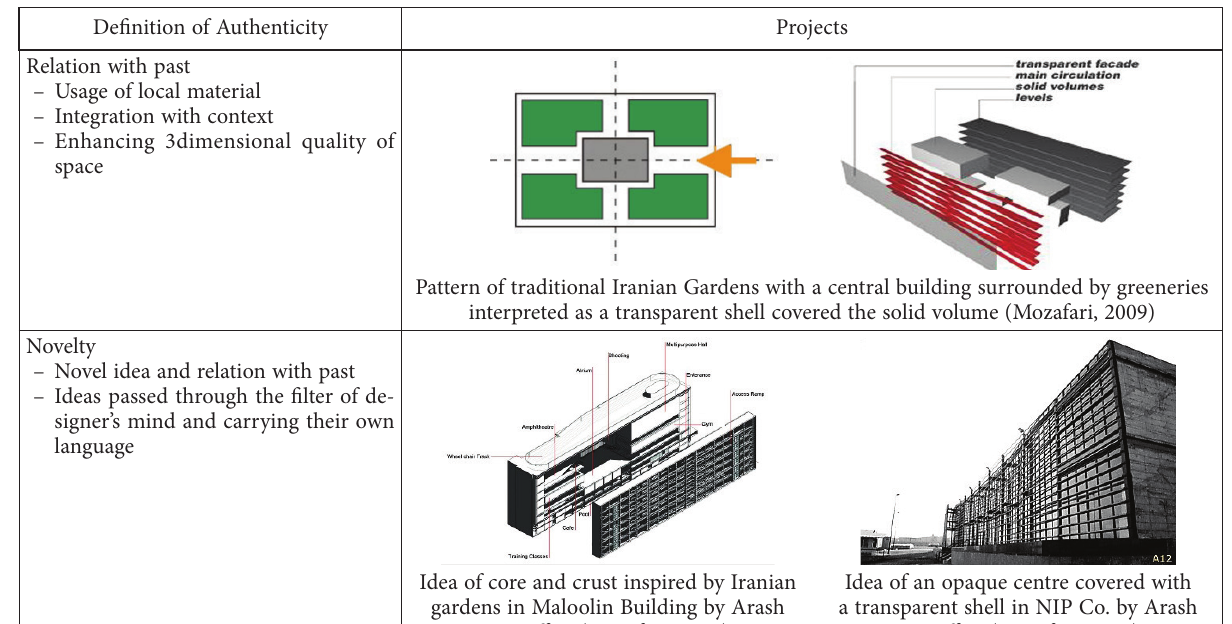
Table 6. Idea of core and crust in the works of Arash Mozaff ari with reference to traditional Iranian